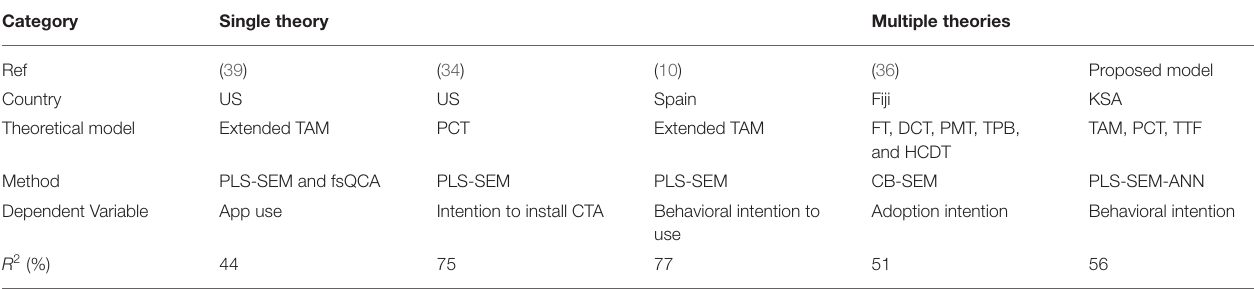
TABLE 11 | Comparison of proposed approach with existing